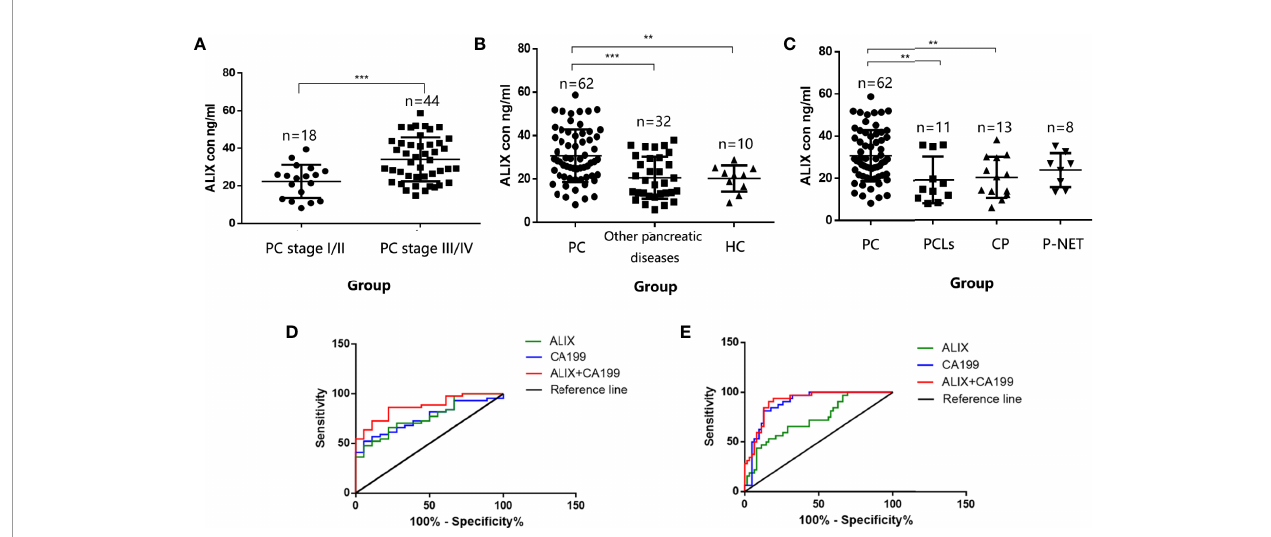
FIGURE 6 | Validation of exosomal ALIX as a novel biomarker for pancreatic cancer diagnosis and classi fi cation. (A) Scatter dot plots of protein concentrations of exosomal ALIX in patients with PC at different stages analyzed by ELISA. (B) Scatter dot plots of protein concentrations of exosomal ALIX in patients with PC, other pancreatic diseases, and healthy controls. (C) Scatter dot plots of protein concentrations of exosomal ALIX in patients with PC compared with all other types of pancreatic diseases. (D) ROC curve analysis of exosomal ALIX and serum CA199 for discrimination between PC patients at stage I/II and stage III/IV. (E) ROC curve analysis of exosomal ALIX and serum CA199 in differentiating PC vs. other pancreatic diseases. ** P < 0.01; *** P <